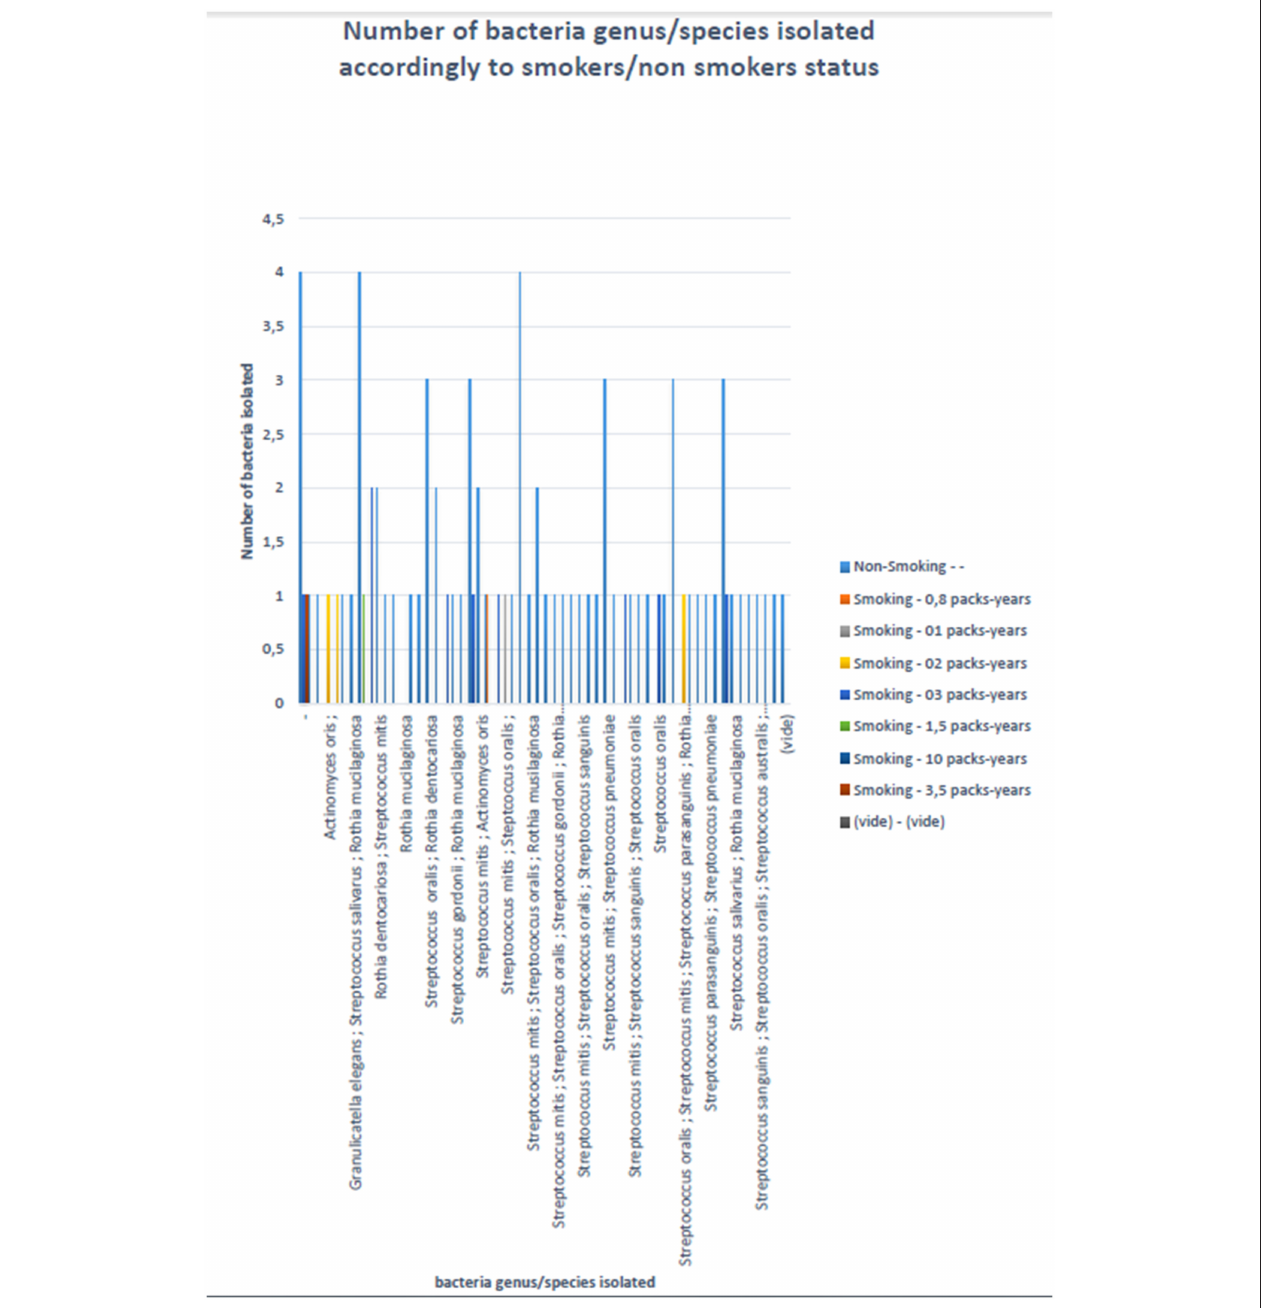
FIGURE 3 | Number of bacterial species accordingly to status tobacco smokers/non-smokers. X-axis: name of the isolated bacterial species; y-axis: number of isolated bacterial species. The color codes represent the status smokers/non-smokers.